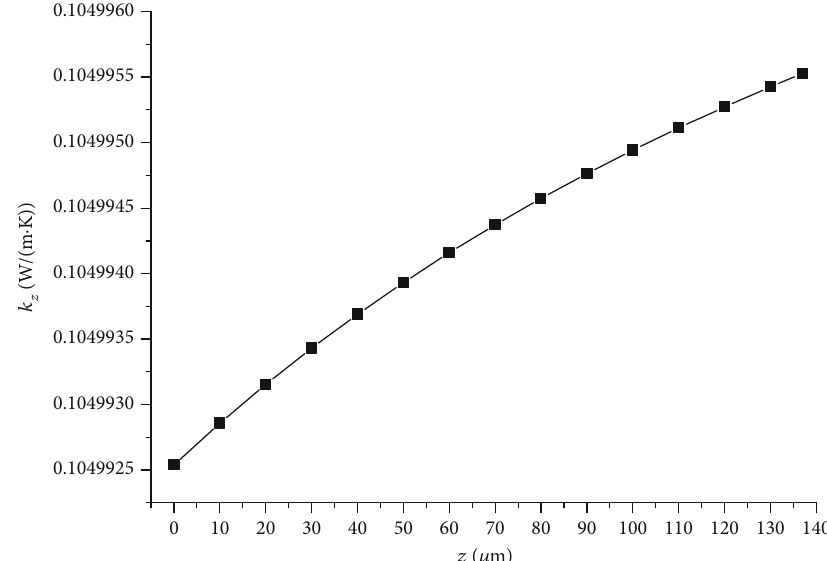
Figure 13: The in fl uence of microsphere distance on heat transfer